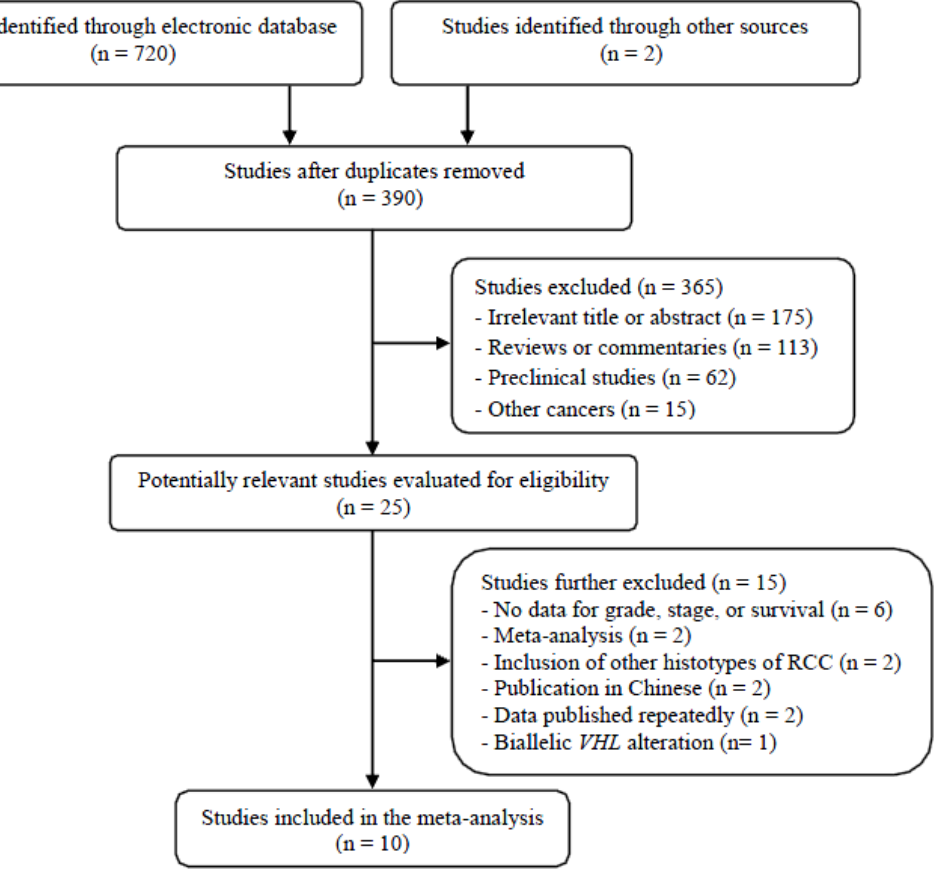
Figure 1. Flow diagram of search process.